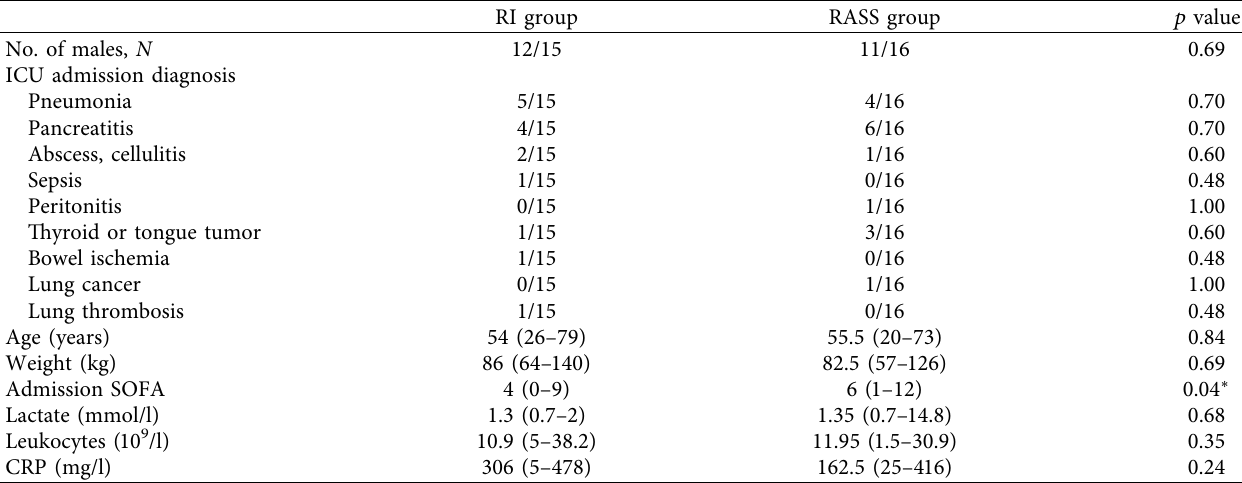
Table 1: Baseline characteristics.